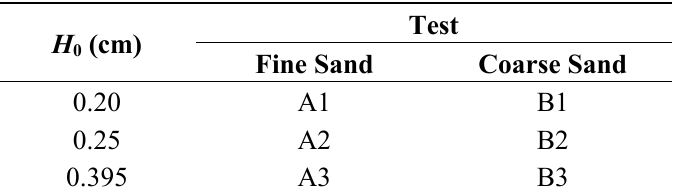
Table 1. List of performed